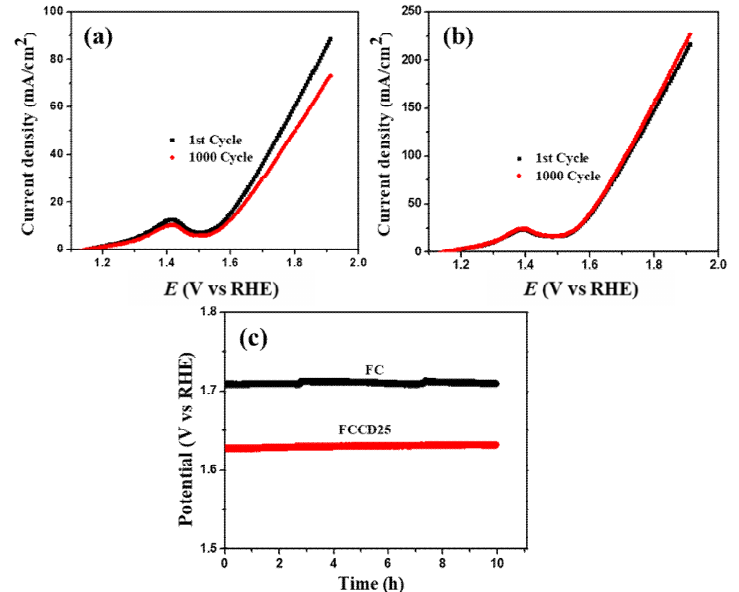
Figure 7. Oxygen evolution reaction (OER) polarization curves of ( a ) FC, ( b ) FCCD25 before and after 1000 CV cycles, ( c ) chronopotentiometric study at a constant current density of 50 mA cm −2 .